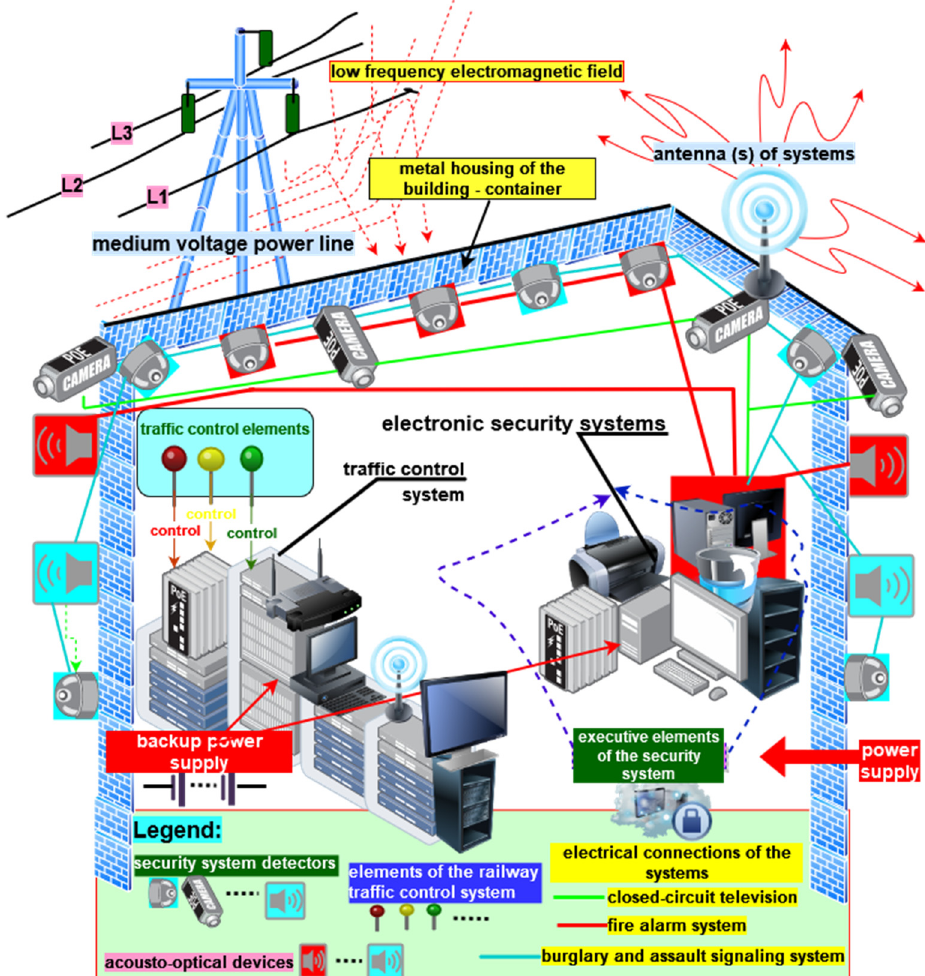
Figure 1. Arrangement of electronic security systems in a metal container due to their important functions within the State’s communication structure. Designations: L1, L2, L3—individual voltage phases found in the overhead power line supplying electricity to transport telematics systems and electronic security systems. The power is supplied from the MV grid and from backup power sources (battery banks for electronic security systems and UPSs for rail transport telematics systems due to the rated power demand).